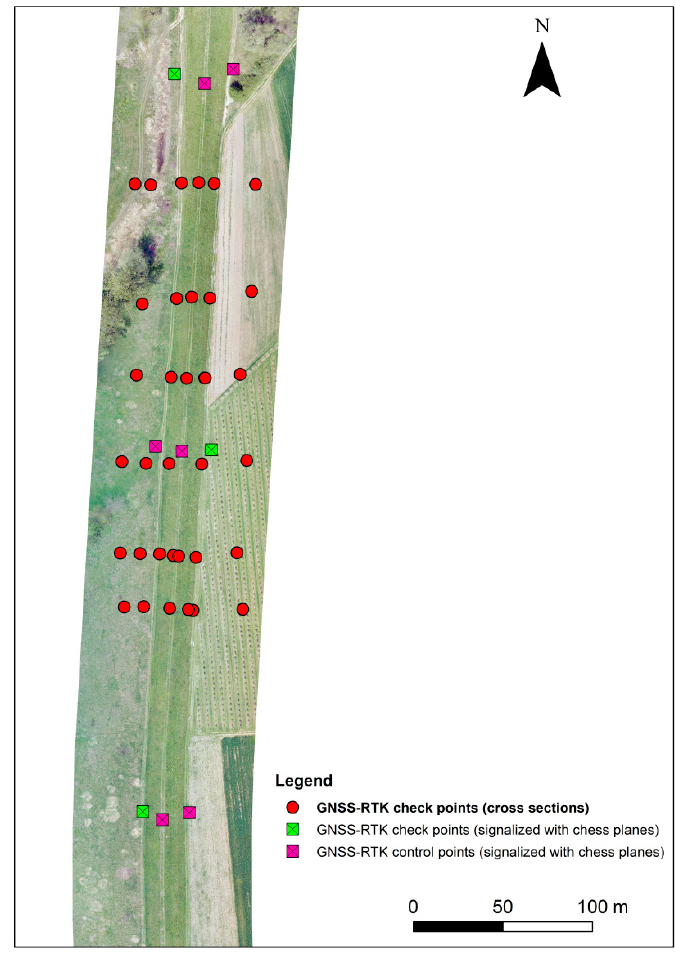
Figure 5. Visualization of the example GNSS-RTK cross-section points.